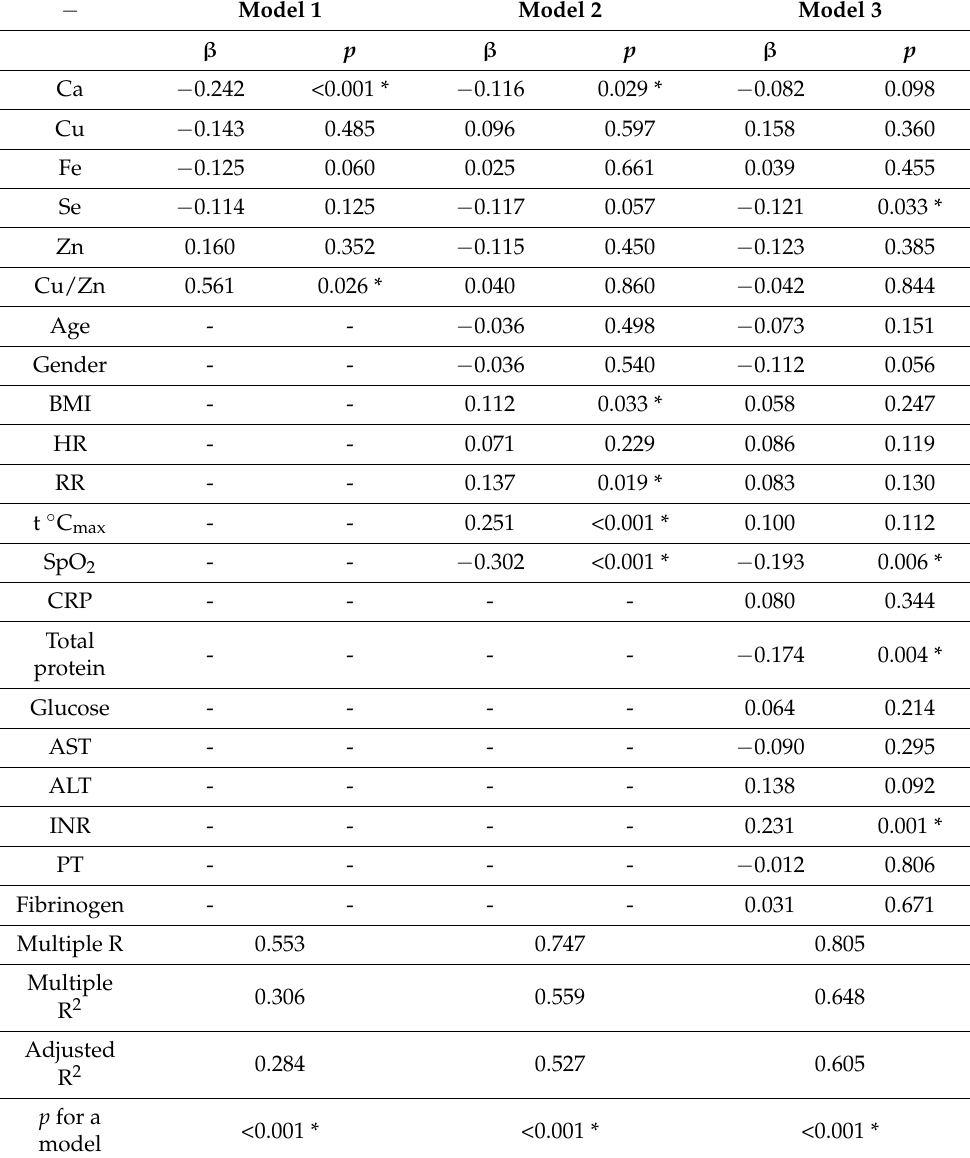
Table 4. Multiple regression analysis of the association between lung damage (dependent variable) and serum metal levels (Model 1) after adjustment for anthropometric and clinical variables (Model 2), and biochemical and hemostatic markers (Model